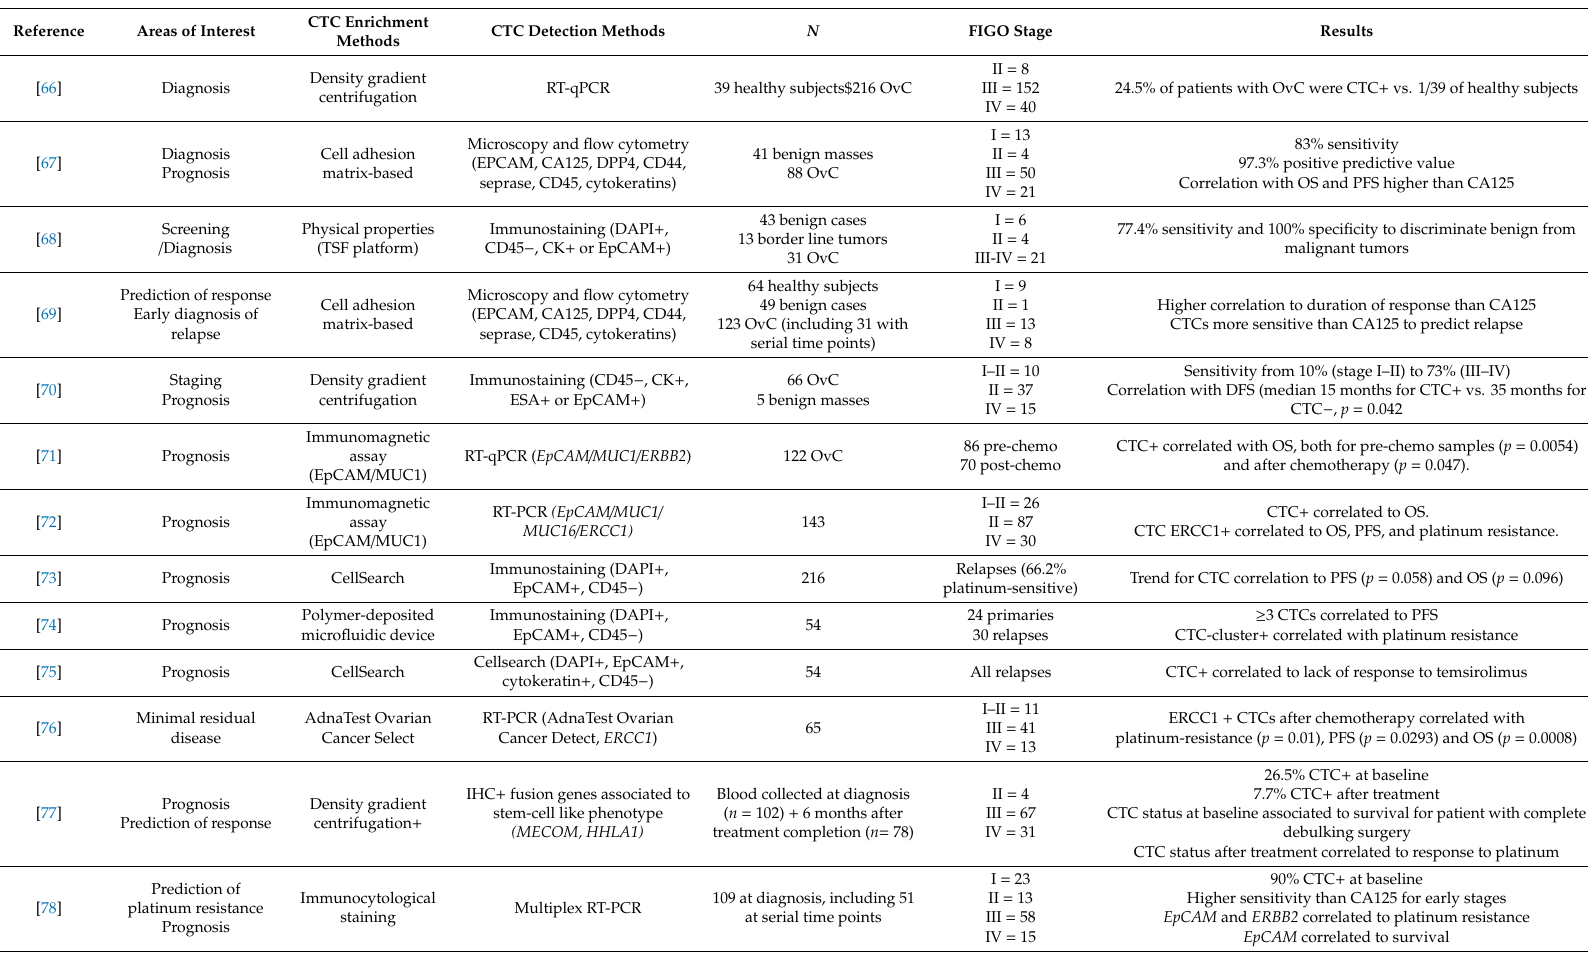
Table 2. Main published works concerning circulating tumor cells analyses for patients with ovarian epithelial cancer. FIGO Stage